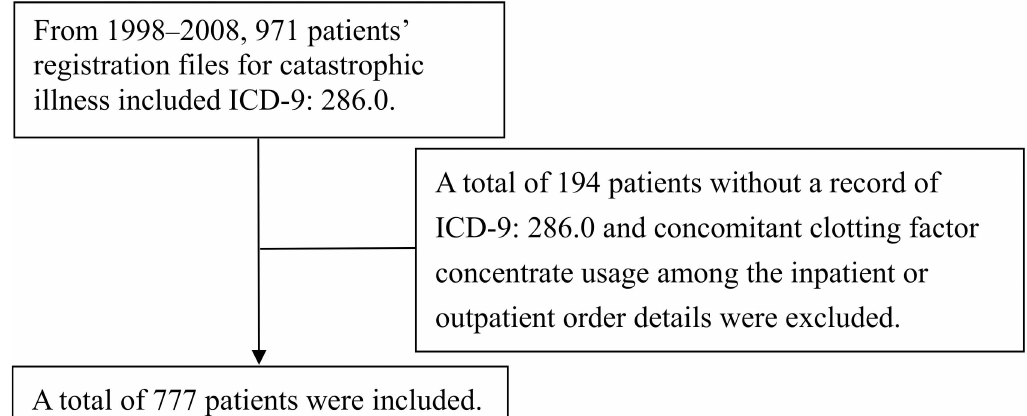
Fig 1. Patient selection flow